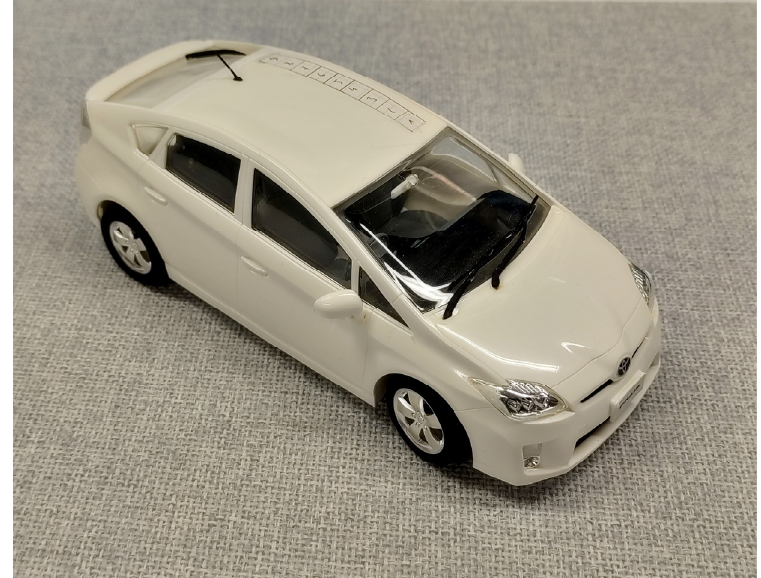
Figure 21. Toyota Prius model from Fujimi at a scale of 1:24.